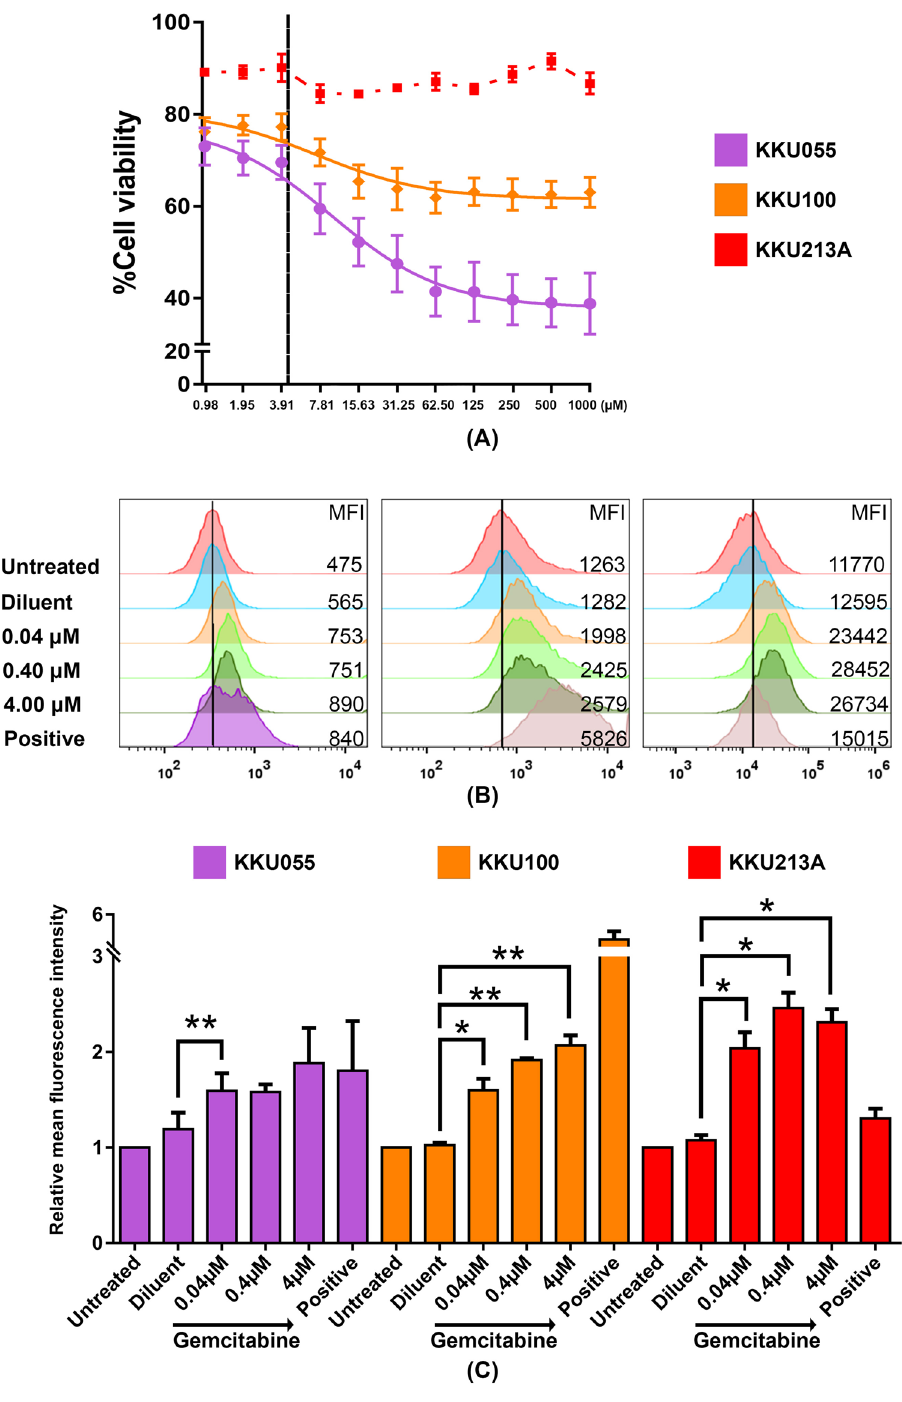
Figure 1. Gemcitabine increased PD-L1 expression in CCA cell lines. ( A ) Cell viability of CCA cell lines after treatment with various concentrations of gemcitabine for 24 h. The vertical black line shows the selected concentration (4 µM) that caused low cytotoxicity to CCA cell lines. ( B ) The histograms and ( C ) bar graph of PD-L1 relative fluorescence intensity comparing to non-treatment control after treatment with gemcitabine for 24 h. Error bars represented the standard error of the mean (SEM) (*p < 0.05, **p < 0.01). Diluent (gemcitabine diluent: normal saline); Positive (IFN-γ 10